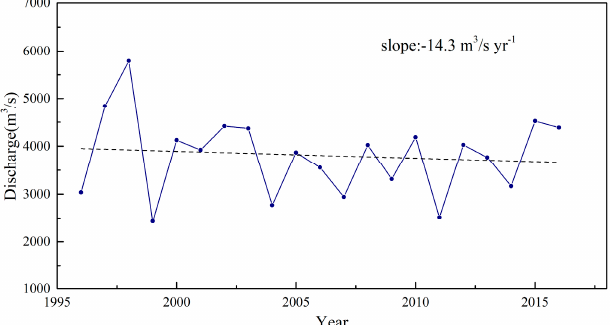
Figure 11. The long term change of the inflow from “four rivers”.